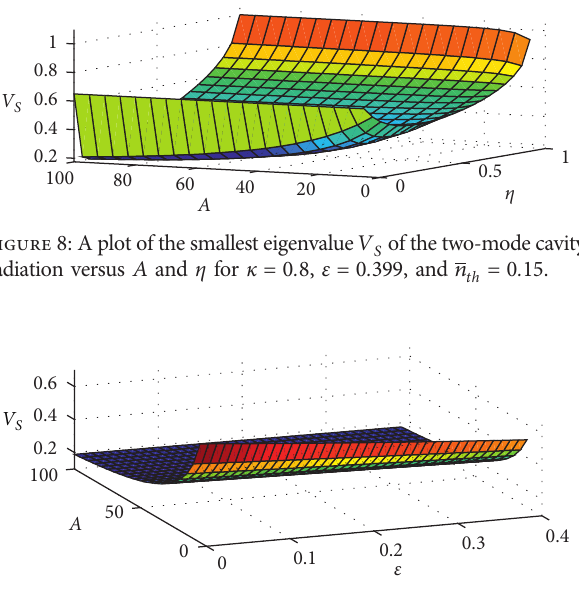
S of the two-mode